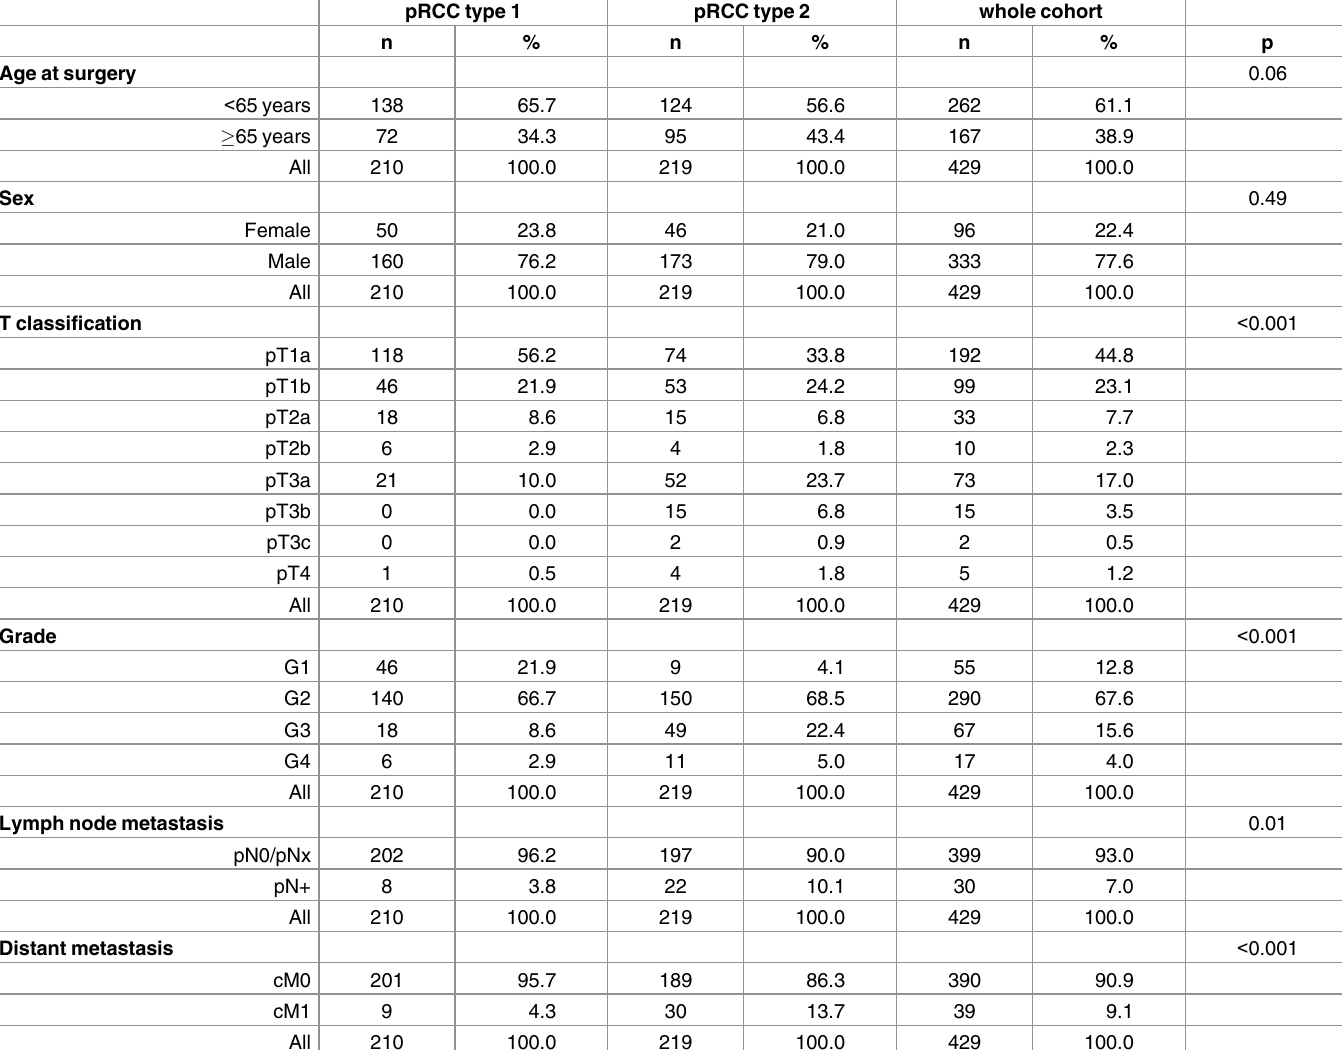
Table 2. Summaryof clinical and pathological features and group differences between pRCC subtypes (pRCC subtypes, n =